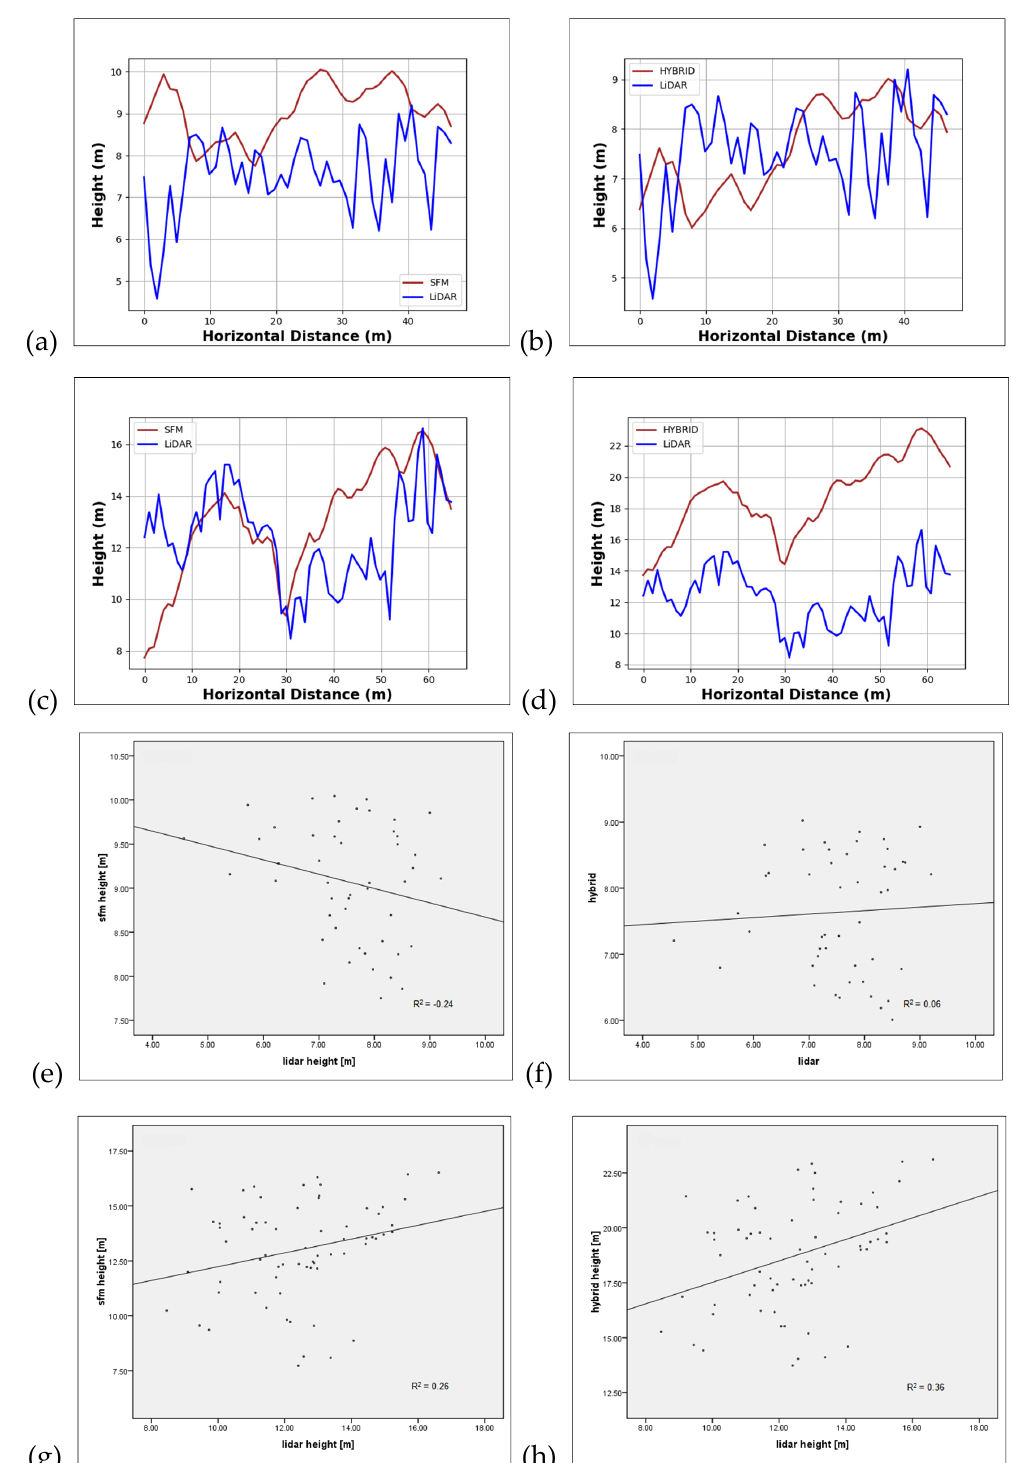
Figure 11. Showing for the Meshaw site; CHM profiles for ( a ) and ( b ) transect 2 and ( c ) and ( d ) transect 4, and corresponding regression plots ( e ) to ( h ). Both SfM and Hybrid CHMs showed strong positive correlation to LiDAR for both transects. However, the Hybrid heights constantly over ‐ estimated the tree heights in both cases.